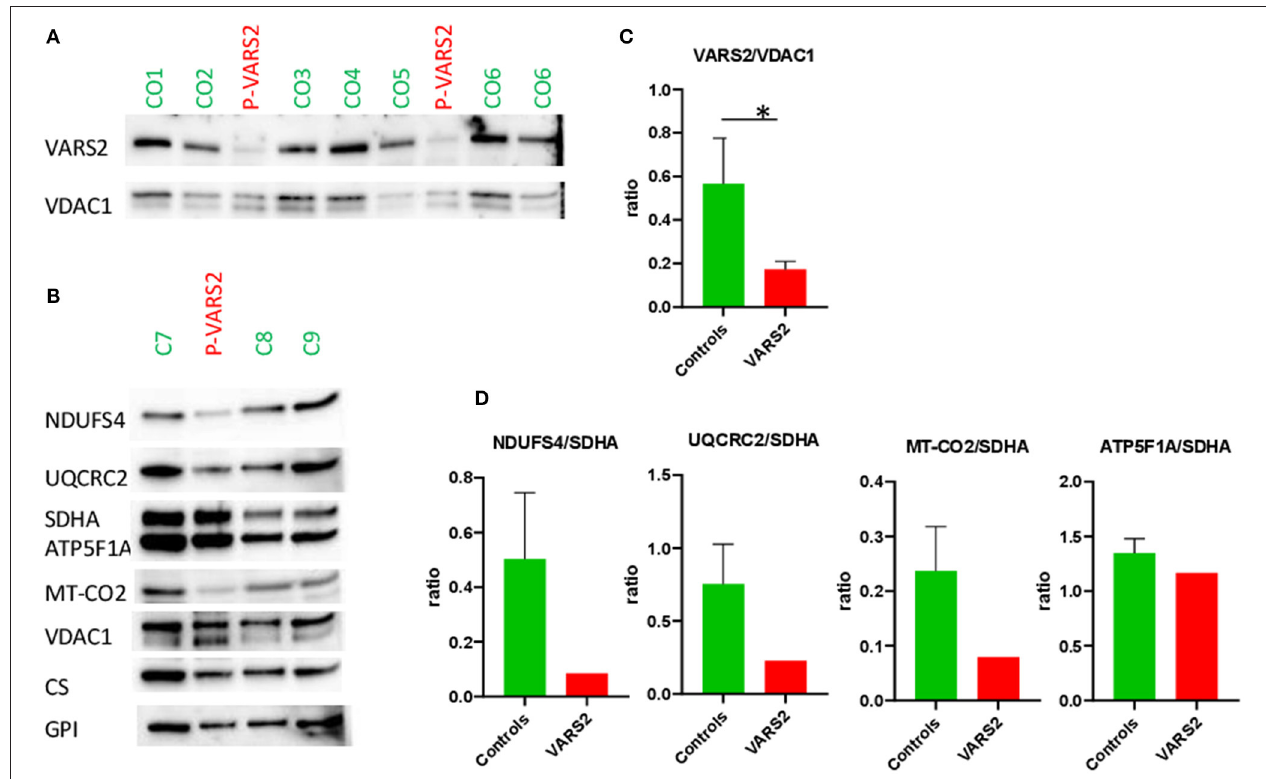
FIGURE 2 | (A,B) Western blot analysis of the muscle sample of the patient compared to healthy controls, using antibodies against VARS2, NADH dehydrogenase [ubiquinone] iron-sulfur protein 4 (NDUFS4), ubiquinol-cytochrome c reductase core protein 2 (UQCRC2), succinate dehydrogenase complex flavoprotein subunit A (SDHA), ATP synthase F1 subunit alpha (ATP5F1A), mitochondrially encoded cytochrome c oxidase II (MT-CO2), voltage-dependent anion-selective channel 1 (VDAC1, in outer mitochondrial membrane), citrate synthase (CS), glucosephosphate isomerase (GPI). (C,D) Bar graphs show the densitometry of the western